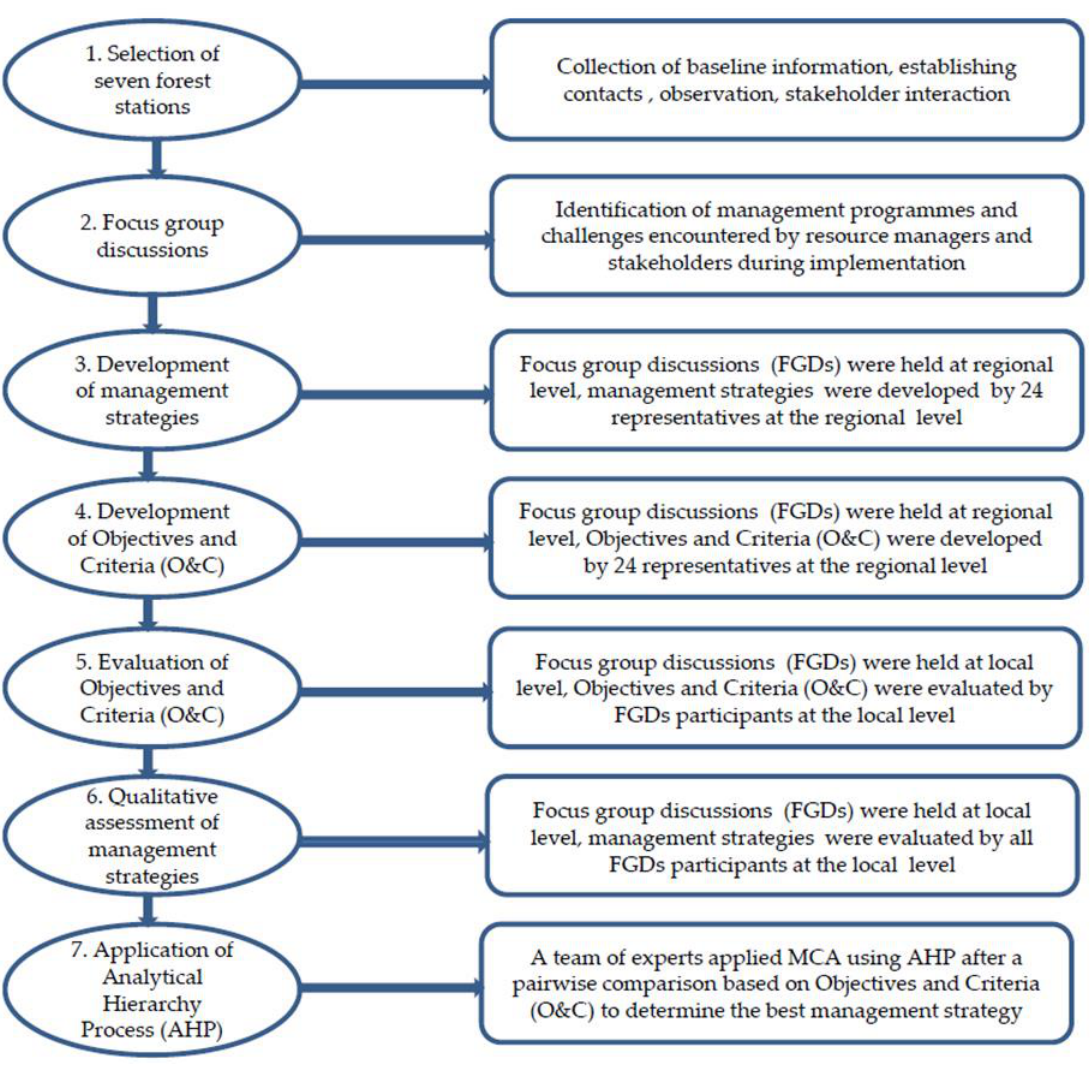
Figure 2. The methodological approach for selecting the best management strategy in Mount Kenya Forest Reserve and National Park (MKFRNP).